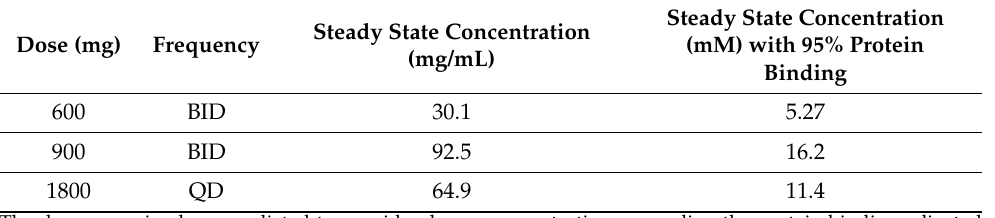
Table 2. Probenecid steady-state concentration and free drug concentrations after different probenecid doses in